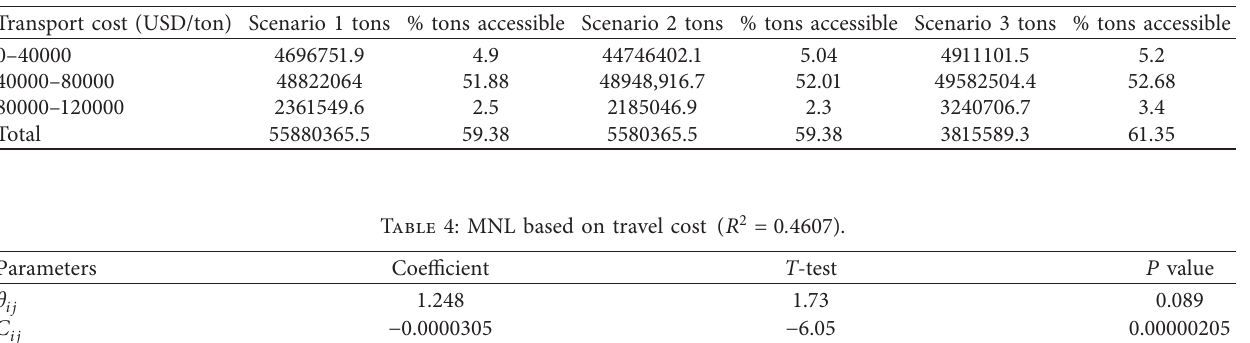
Table 3: Cumulative opportunities accessibility measure per scenario.